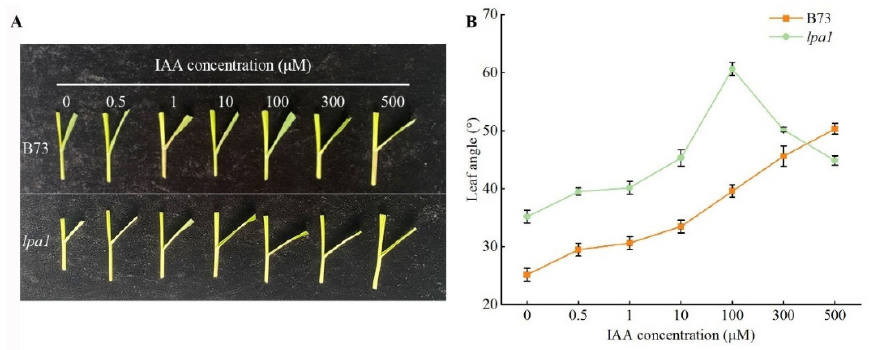
Figure 4. Effects of exogenous hormones on leaf angle of wild-type B73 and mutant lpa1 . ( A ) Effects of different concentrations of IAA on leaf angle of wild type and mutant. ( B ) Size of leaf angle for wild type and mutant under different concentrations of IAA treatment.